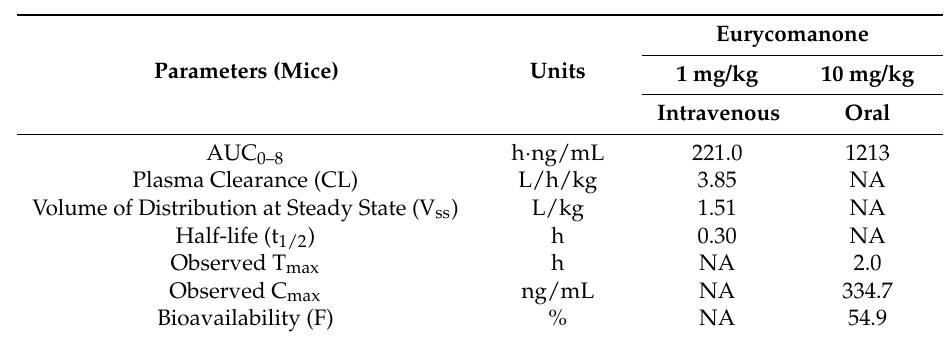
Table 1. Summary of pharmacokinetic parameters following an intravenous and oral dose of eurycomanone to mice.